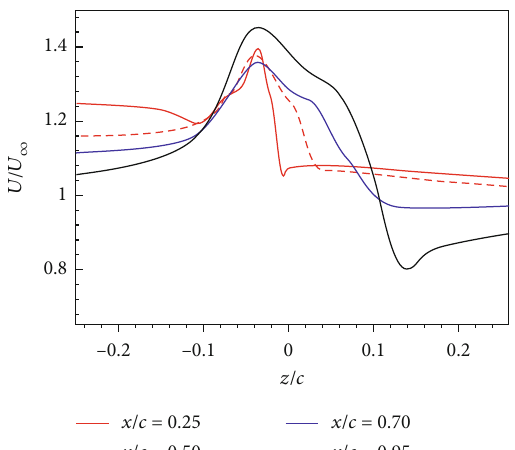
Figure 8: Axial velocity of the primary vortex.